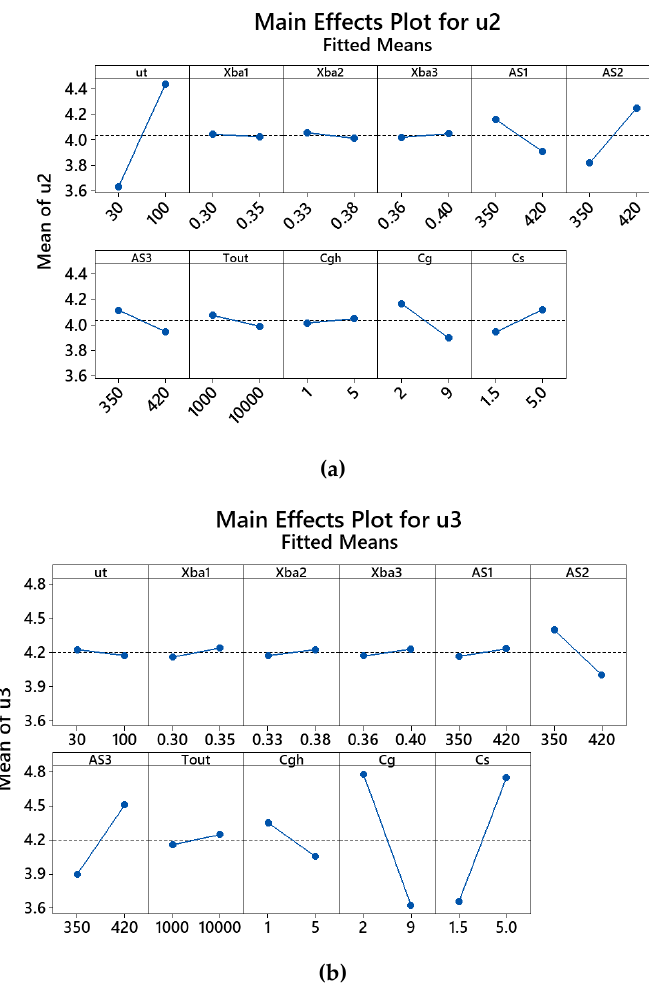
Figure 4. Main effects plot for (a) 𝑢 (cid:2870) and (b) 𝑢 (cid:2871) . Figure 4. Main e ff ects plot for ( a ) u